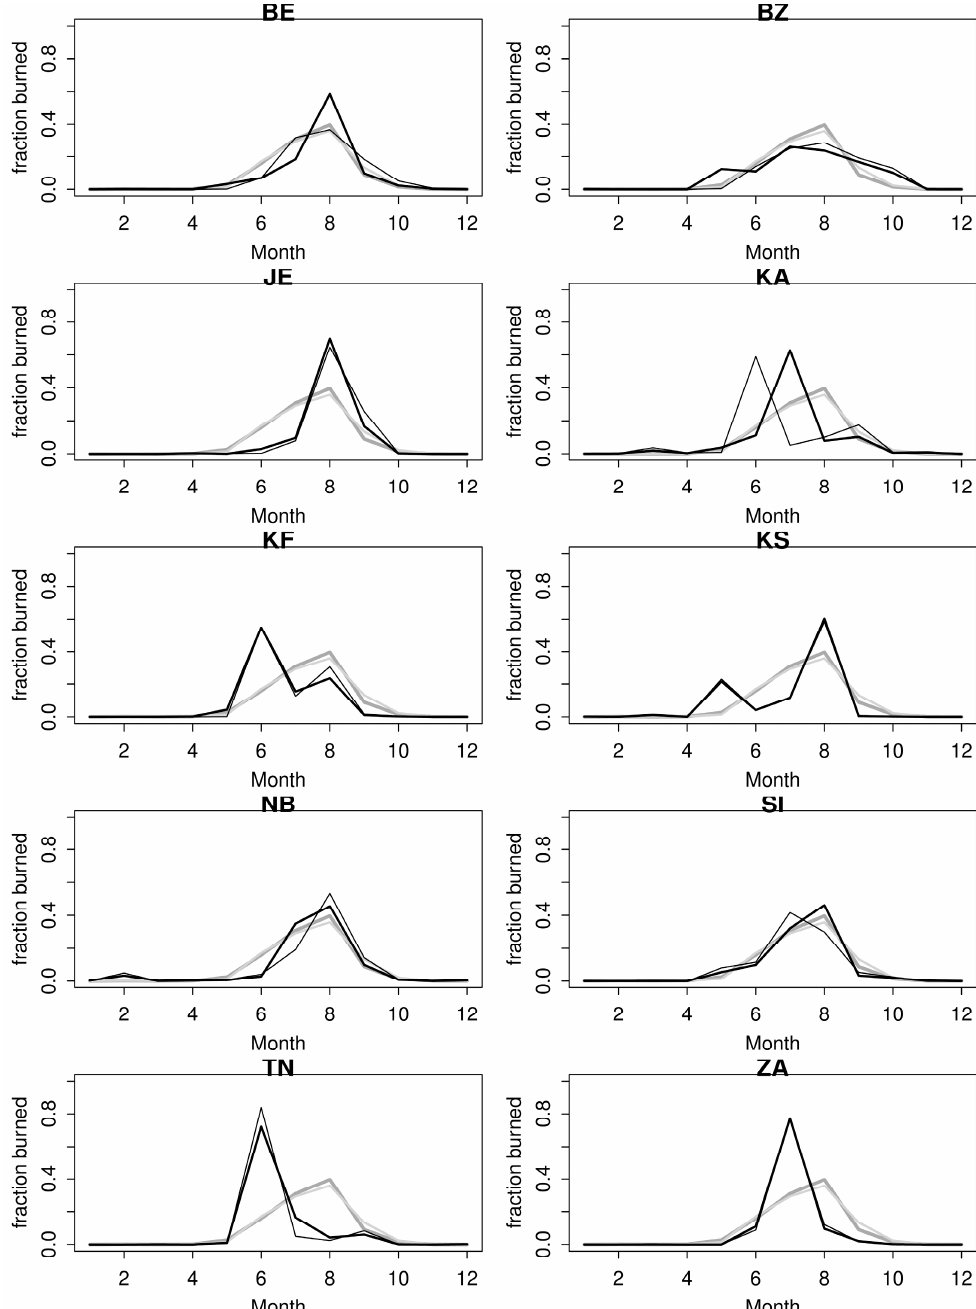
Figure 12. Seasonal pattern of burned area for each gouvernorat in Tunisia from the DGF (black thin line) and COR (black thick line). For comparison, the seasonal pattern of burned area for the whole Tunisia (grey lines) is also plotted as a background of each gouvenorat (thin line, DGF; thick line, COR).